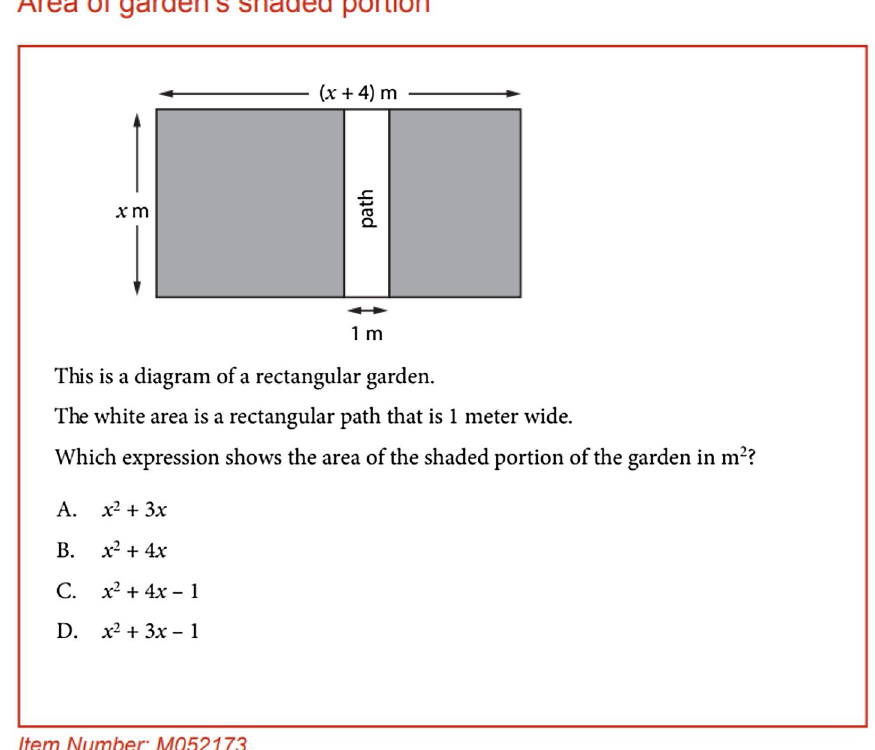
Fig. 1 Example item of the TIMSS 2011 8th grade mathematics test (Mullis et al.,